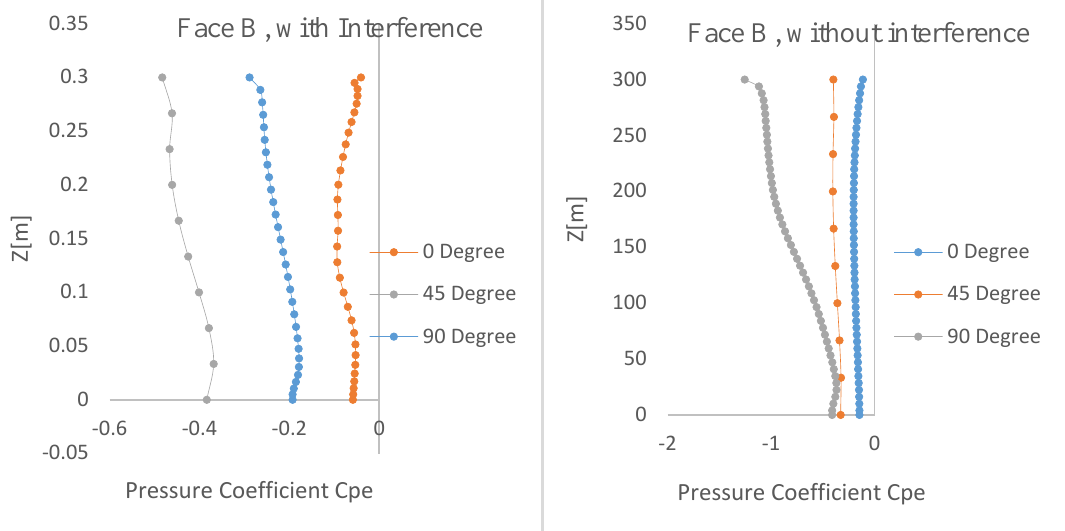
Fig. 7. Variation of pressure coefficient with height for Face B with Interference and without interference.